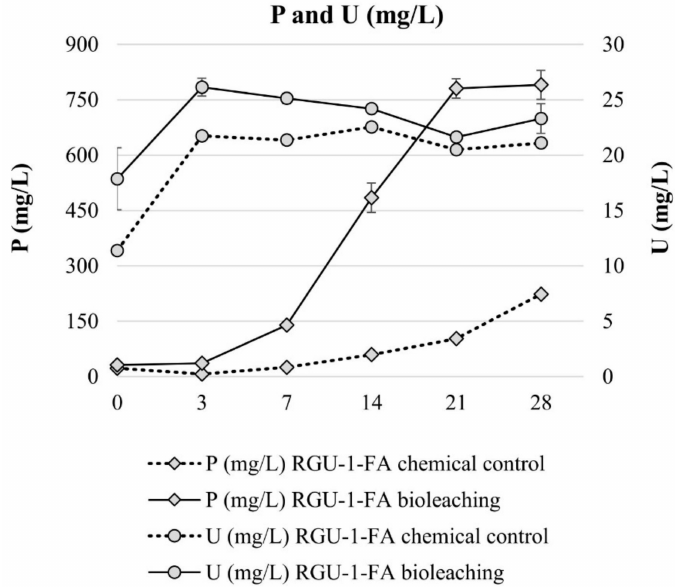
Figure 5. Evolution of P and U concentrations during bioleaching and chemical leaching of RGU-1-FA ore; phosphorus and uranium concentrations (mg / L). The x-axis represents the leaching duration